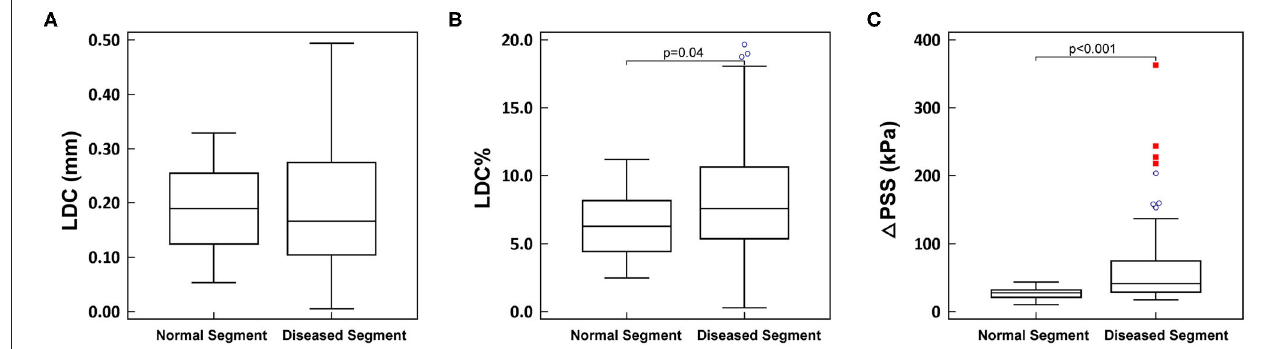
FIGURE 4 | (A–C) Comparison between normal segment and diseased segment. LDC, lumen diameter change; LDC%, percent lumen diameter change; 1 PSS, delta plaque structural stress. The blue circles represent the mild outliers, and the red boxes represent the extreme